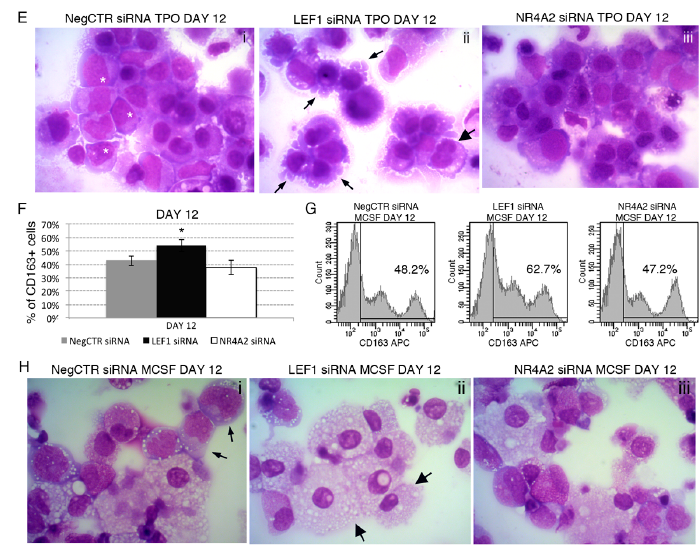
Figure 6. Effects of LEF1 and NR4A2 silencing on megakaryocyte and macrophage differentiation. ( A , B ) Flow cytometric analysis (mean ± SEM; n = 3) of CD41 and CD42b expression at day 4 ( A ) and day 8 ( B ) of TPO-driven megakaryocyte unilineage culture post-nucleofection; ( C ) Representative dot plots for the flow cytometric detection of CD41 and CD42b differentiation markers at day 8 of megakaryocyte unilineage culture post-nucleofection; ( D , E ) Morphological analysis of NegCTR siRNA ( i ), LEF1 siRNA ( ii ) and NR4A2 siRNA ( iii ) cells after May–Grunwald–Giemsa staining at day 8 ( D ) and day 12 ( E ) of megakaryocyte unilineage culture post-nucleofection in a representative experiment. White asterisks indicate megakaryoblasts, that are immature cells of the megakaryocyte lineage characterized by a higher nucleus-to-cytoplasm ratio compared to mature megakaryocytes. The white arrow highlights a large megakaryocyte. Black thick arrows indicate polyploid megakaryocytes; black thin arrows indicate cells with cytoplasmic blebs, which are a feature of the megakaryocyte maturation in vitro. Magnification, × 1000; ( F ) Flow cytometric detection (mean ± SEM; n = 3) of the CD163 marker at day 12 of MCSF-driven monocyte/macrophage unilineage culture post-nucleofection; ( G ) Representative histograms for the flow cytometric detection of CD163 marker at day 12 of monocyte/macrophage unilineage culture post-nucleofection; ( H ) Morphological analysis of NegCTR siRNA ( i ), LEF1 siRNA ( ii ) and NR4A2 siRNA-transfected cells ( iii ) after May–Grunwald–Giemsa staining at day 12 of monocyte/macrophage unilineage culture post-nucleofection in a representative experiment. Thick arrows indicate macrophages; thin arrows indicate monocytes. Magnification, × 1000. Data are from n = 3 independent experiments performed with different healthy donor-derived cord blood units. * p ≤ 0.05 compared to NegCTR siRNA sample. Abbreviations: TPO, thrombopoietin; MCSF, monocyte colony-stimulating